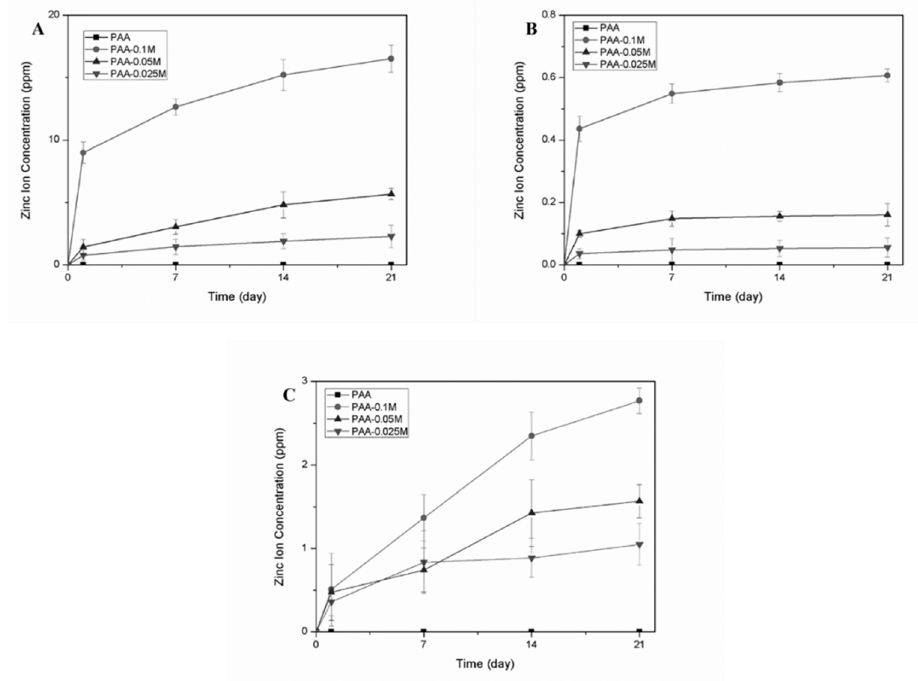
Figure 3. The zinc ion release of PAA, PAA–0.1M, PAA–0.05M and PAA–0.025M in ( A ) DMEM, ( B ) PBS and ( C ) SBF after 1, 7, 14 and 21 days, as detected by AAS.